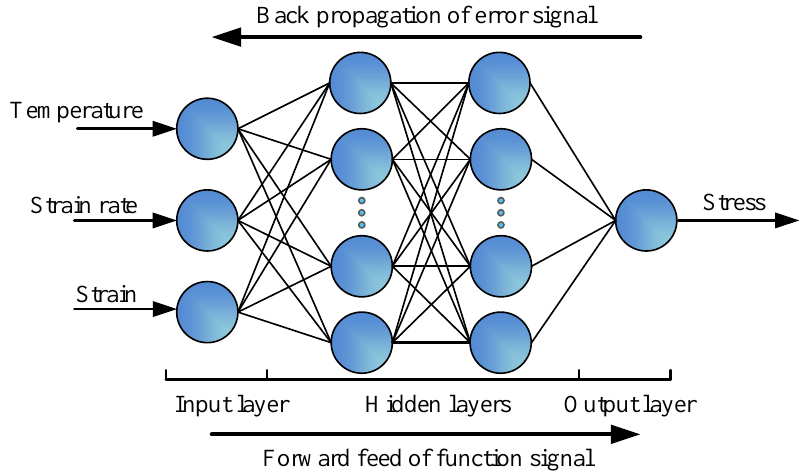
Figure 5. The schematic representation of the artificial neural network (ANN) architecture.